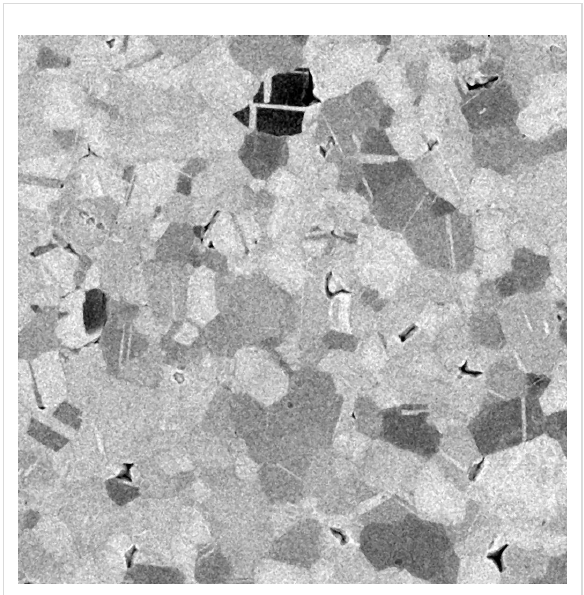
Figure 2: HIM BSHe images of the hydrogen-flame-annealed poly- crystalline Au{111} film. A PE of 20 keV and an ion dose of 1.11 × 10 15 cm − 2 has been used. The stage tilt was 0°. FOV: 15